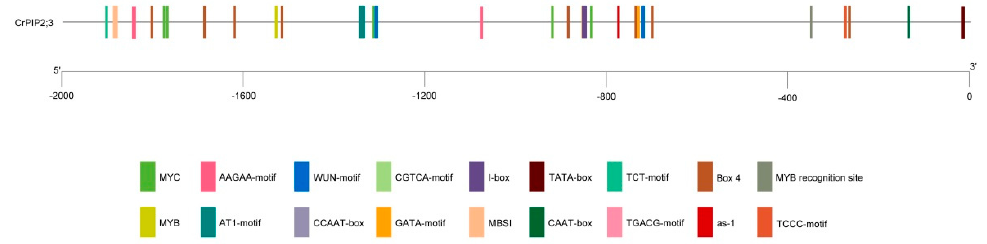
Figure 2. Cis ‐ acting elements analysis of the putative promoter region of CrPIP2;3 (ATG 2000 bp upstream).